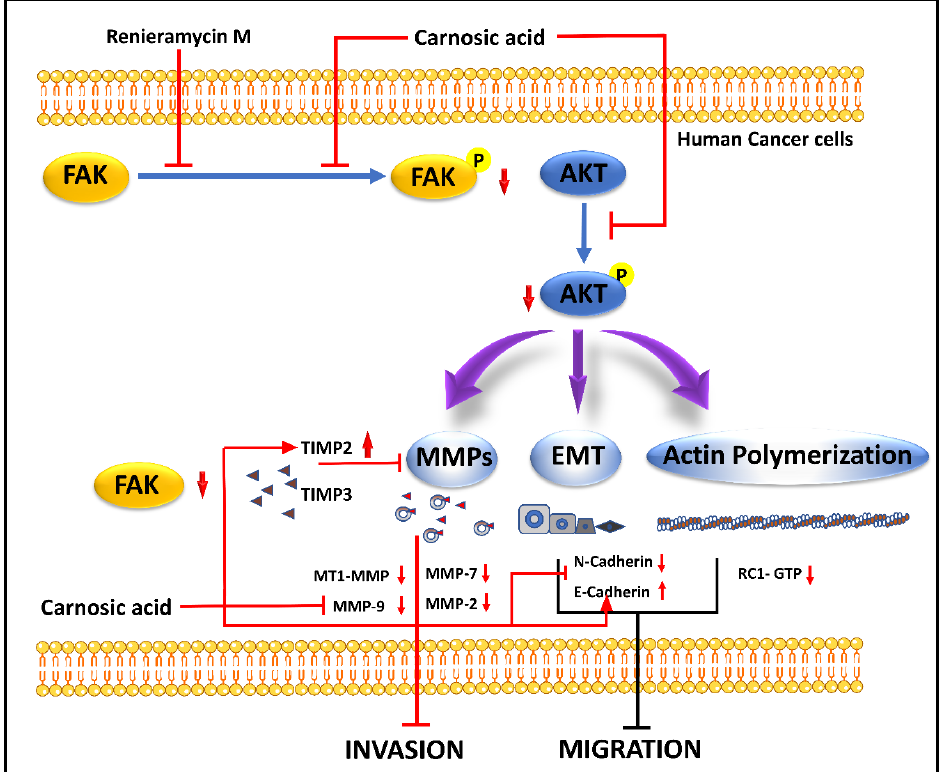
Figure 3. Inhibition of the FAK/AKT signaling pathway and subsequently decrease EMT markers, CDH2 MMPs, etc., and increases epithelial marker, E-cadherin, which reduces cell invasion and migration by Renieramycin M and Carnosic Acid [94,95].